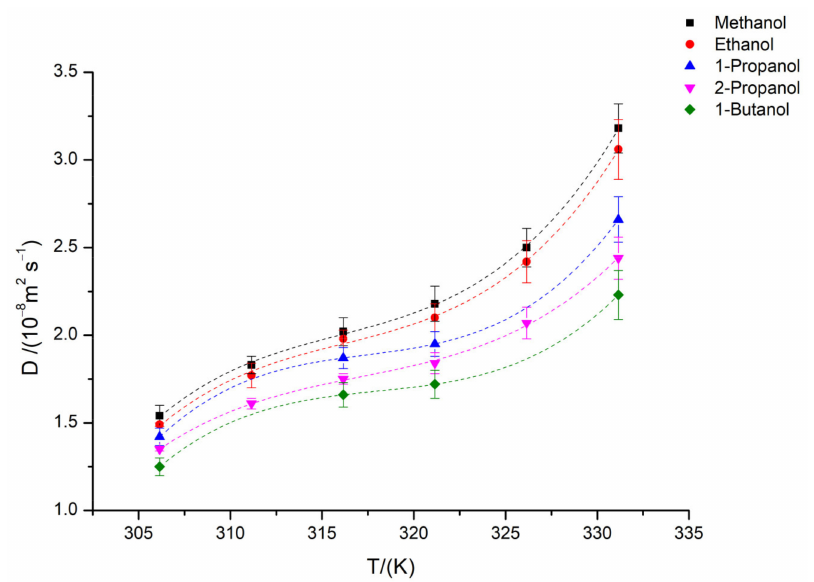
Figure 1. Diffusion coefficient for methanol, ethanol, 1-propanol, 2-propanol, and 1-butanol in scCO 2 at p = 10.5 MPa and at different temperatures from 306.15 to 331.15 K. Dots are experimental values and dashed lines the